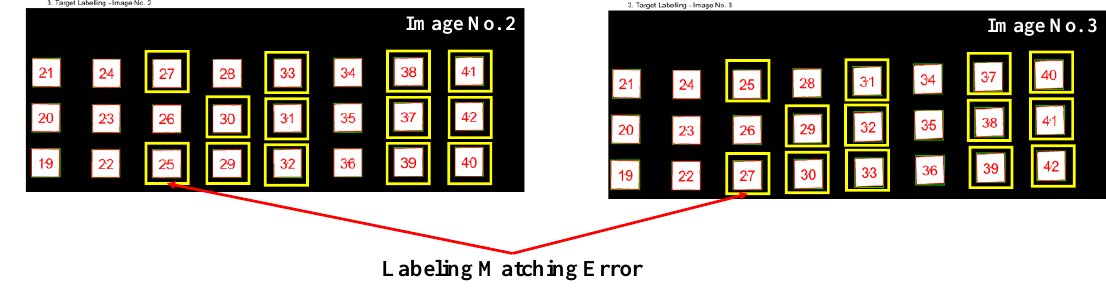
Figure 6. TP label mismatch.